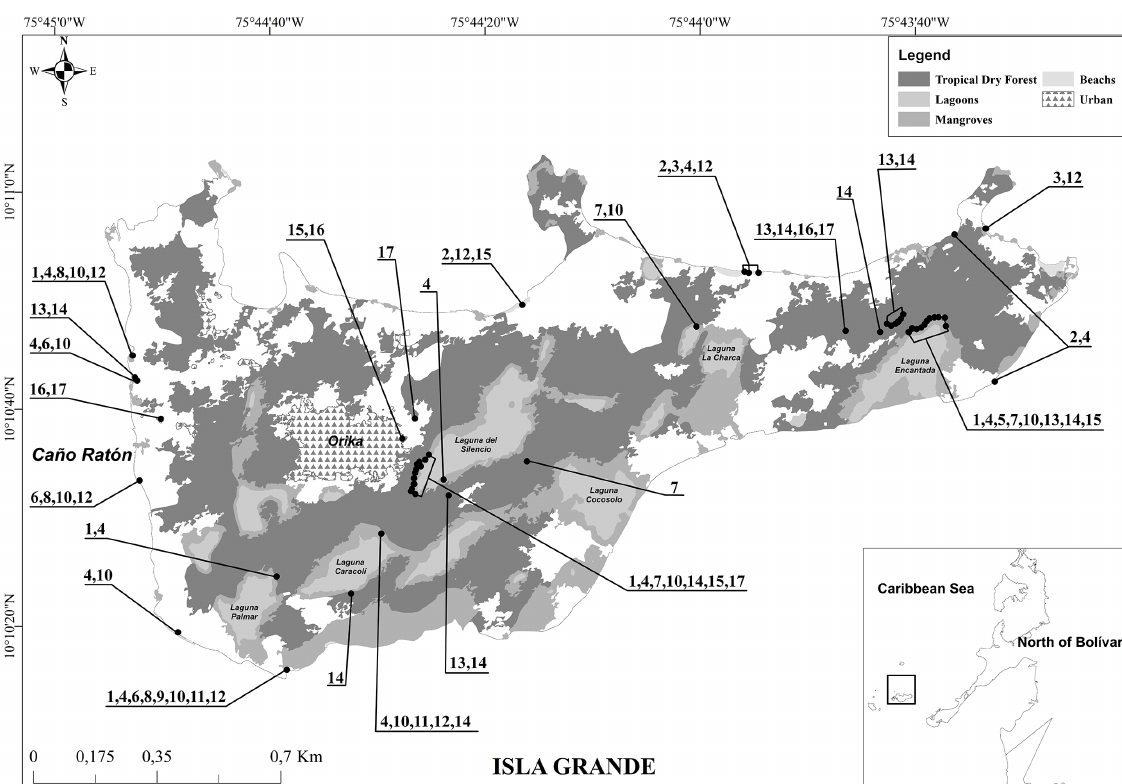
(Fig. 1). The climate classification is semi-arid tropical domain, with an average annual temperature of 24.7°C (min 21°C, max 33°C), average annual precipitation of 916 mm and humidity ranging between 80% and 85% (Pineda et al. 2006; Niño et al. 2010).